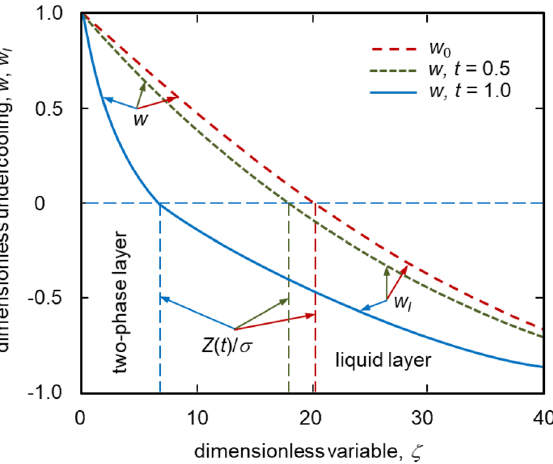
Figure 3. Dimensionless undercooling in the two-phase ( w > 0 ) and liquid ( w l < 0 ) layers as a function of dimensionless coordinate ζ . The dashed line shows zero approximation w 0 whereas the dotted and solid curves illustrate the first approximation w at different times t . The vertical lines illustrate the interface positions Z ( t )/σ dividing two-phase and liquid layers. The dimensionless undercooling as a function of self-similar varaible ζ is 0.5 (dotted line) and t 1 (solid line). The dashed line representing the main contribution w 0 is shown for t = = 1 independent of t . All curves are plotted for n =